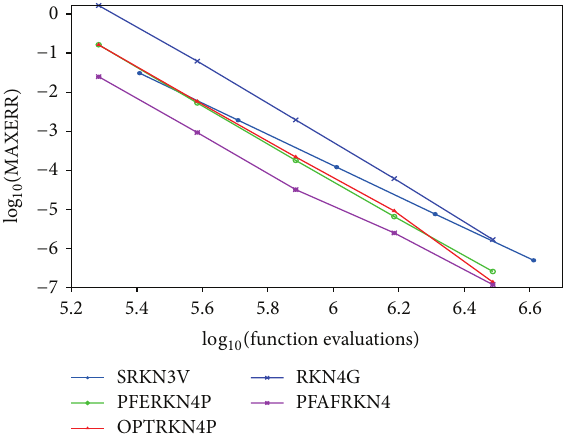
Figure 4: Efficiency curves for all methods for Problem 1 with 𝑒 = 0.3 and ℎ = 1/2 𝑖 , 𝑖 = 3, ...,7 .